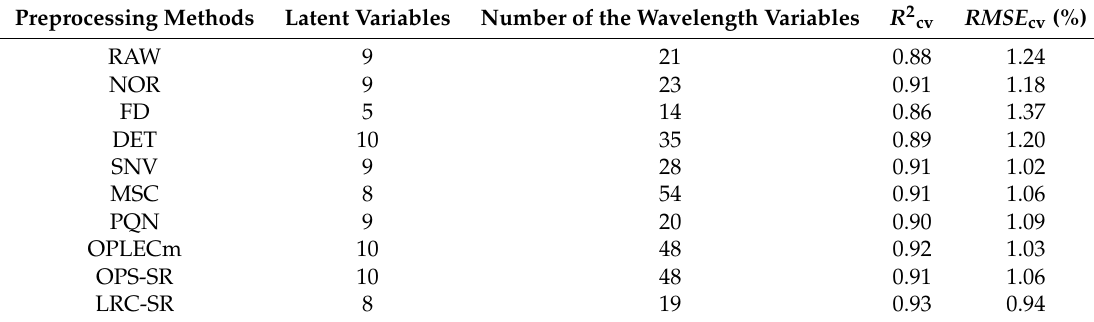
Table 2. The partial least squares regression modeling results of the cross-validation for pear juiciness based on the characteristic wavelengths using di ff erent preprocessing